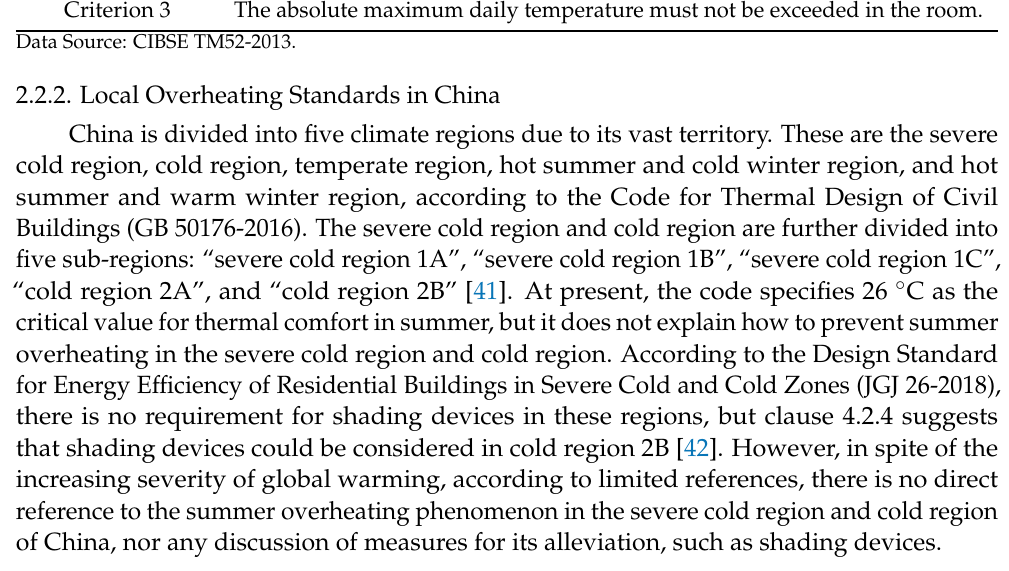
Table 1. Three criteria for overheating from CIBSE TM52-2013. Criteria Content The operative temperature exceeds the threshold comfort temperature Criterion 1 (upper limit of comfort temperature range) by 1 K or more during the occupied time in the typical non-heating season (1 May to 30 September). Criterion 2 The severity of overheating on any day shall not exceed the limit. Criterion